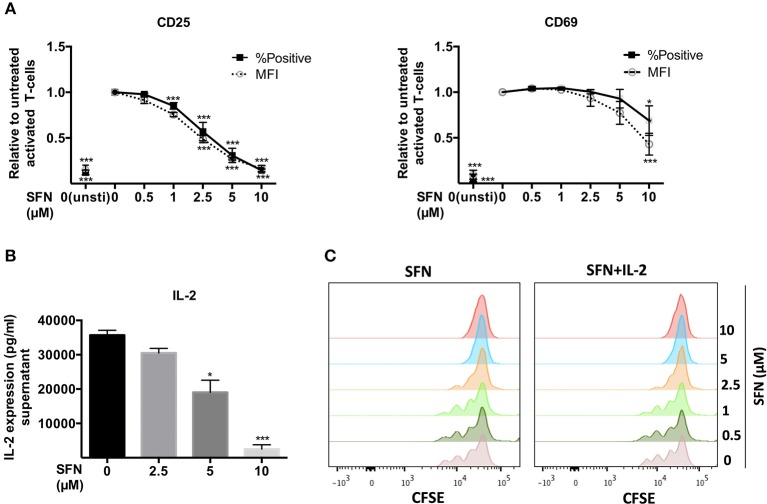
SFN inhibits activation of untransformed human T-cells. (A) Flow cytometry analysis of CD25 and CD69 surface expression in T-cells post 12 h stimulation with anti-CD3(20 ng/ml)/CD28(5 μg/ml) antibodies or unstimulated T-cells (unsti). Given are expression levels relative to the stimulated control (no SFN treatment) in terms of %positive cells (black square, solid line) and mean fluorescence intensities (MFI, open circle, dashed line) (n = 3; mean; SE; *p < 0.05, ***p < 0.001). (B) Quantification of IL-2 production in the supernatant of T-cells without (black histogram) or with SFN (gray histograms) treatment as indicated (n = 3; mean; SE; *p < 0.05, ***p < 0.001). (C) T-cell proliferation detected via staining of CFSE. T-cells were co-stimulated in the absence/presence of SFN without /with addition of exogenous IL-2. CFSE signals were measured by flow cytometry after 3 days of co-stimulation. Histograms are representative for three experiments.